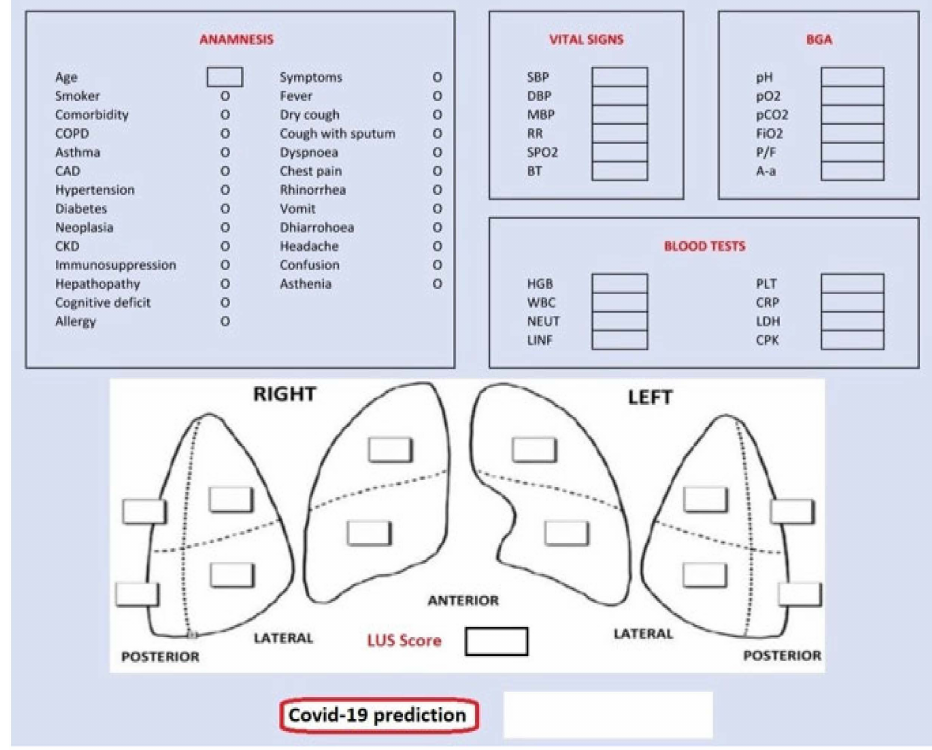
Figure 7. Graphical user interface